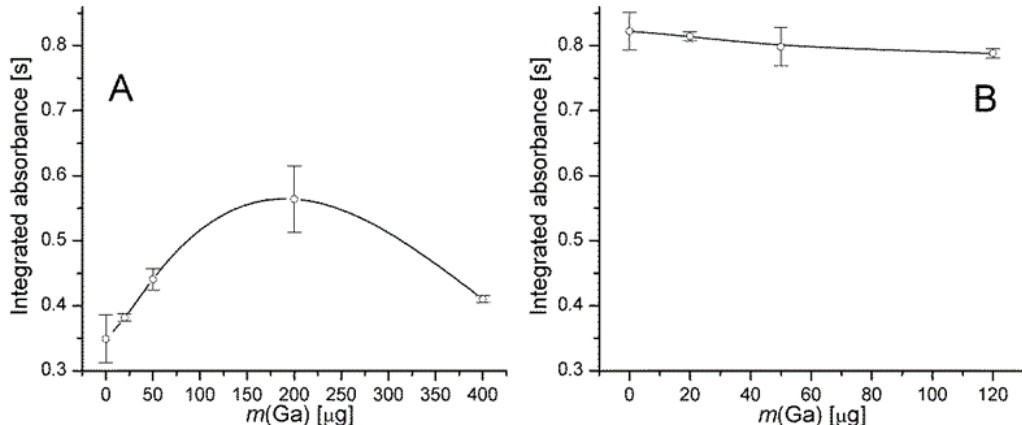
Figure 5. Dependence of GaF molecule absorbance at 211.248 nm on Ga mass added to the sample solution after furnace pretreatment with 60 μ g ( A ) and 800 μ g ( B ) of Ga; T pyrol. = 600 °C; T vapor. = 1540 °C; m (Pd) = 7.5 μ g; m (Zr) = 0.15 μ g; m (Ru) = 1.0 μ g; m (CH 3 COONa) = 5.0 μ g.